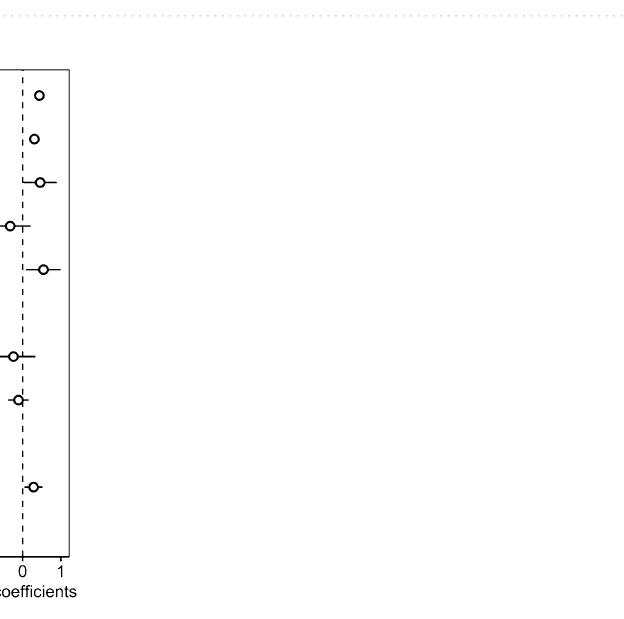
Figure 7. The estimated model averaged coefficients of the prey species model in paddies. Error bars represent standard errors.